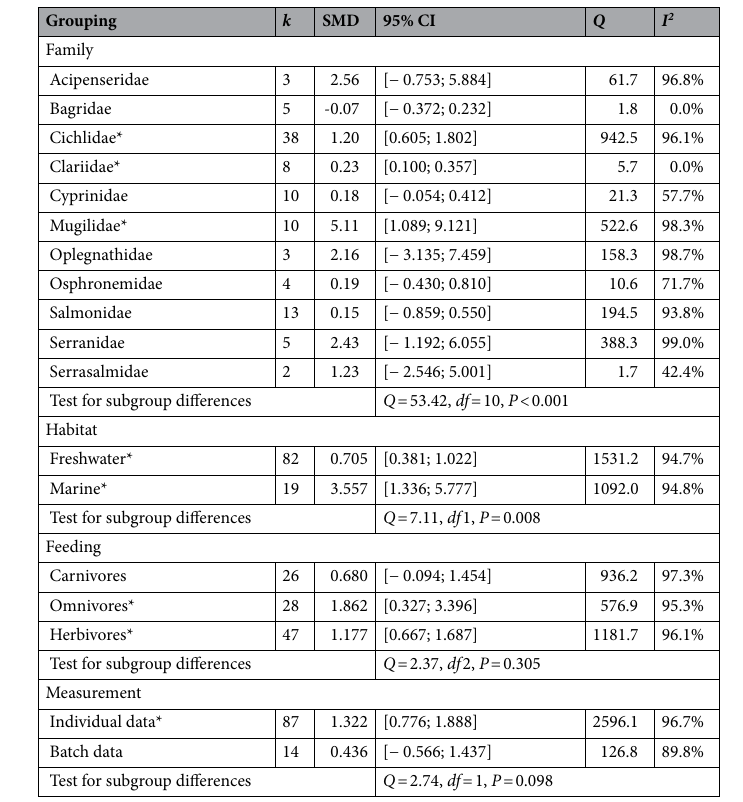
Table 2. Sources of heterogeneity and subgroup analysis in the Spirulina dataset according to a random effects model. Groups that display a positive effect of Spirulina on specificgrowth rate are denoted by an